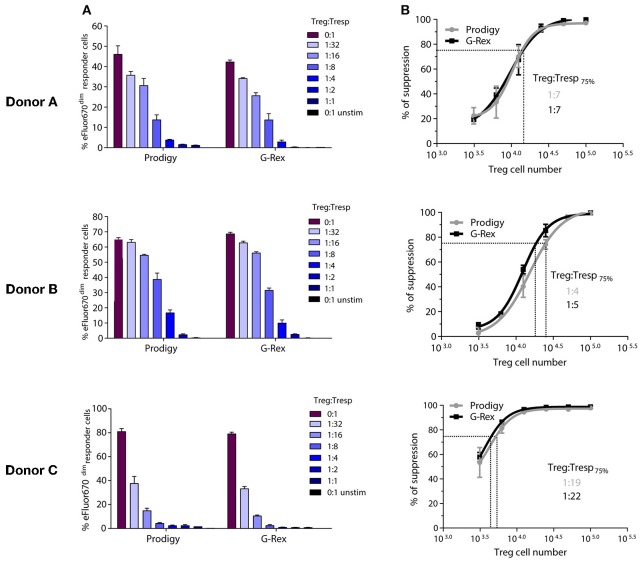
Suppressive capacity of manufactured Treg. Functionality of the final Treg products expanded by manual or automated culture was tested in a proliferation based suppression assay. (A) Percentage of proliferating T responder cells (Tresp) at different Treg:Tresp ratios. Each panel shows one donor. (B) Same data expressed as % of suppression and the estimate of the Treg:Tresp ratio required for 75% suppression. Error bars = SD.